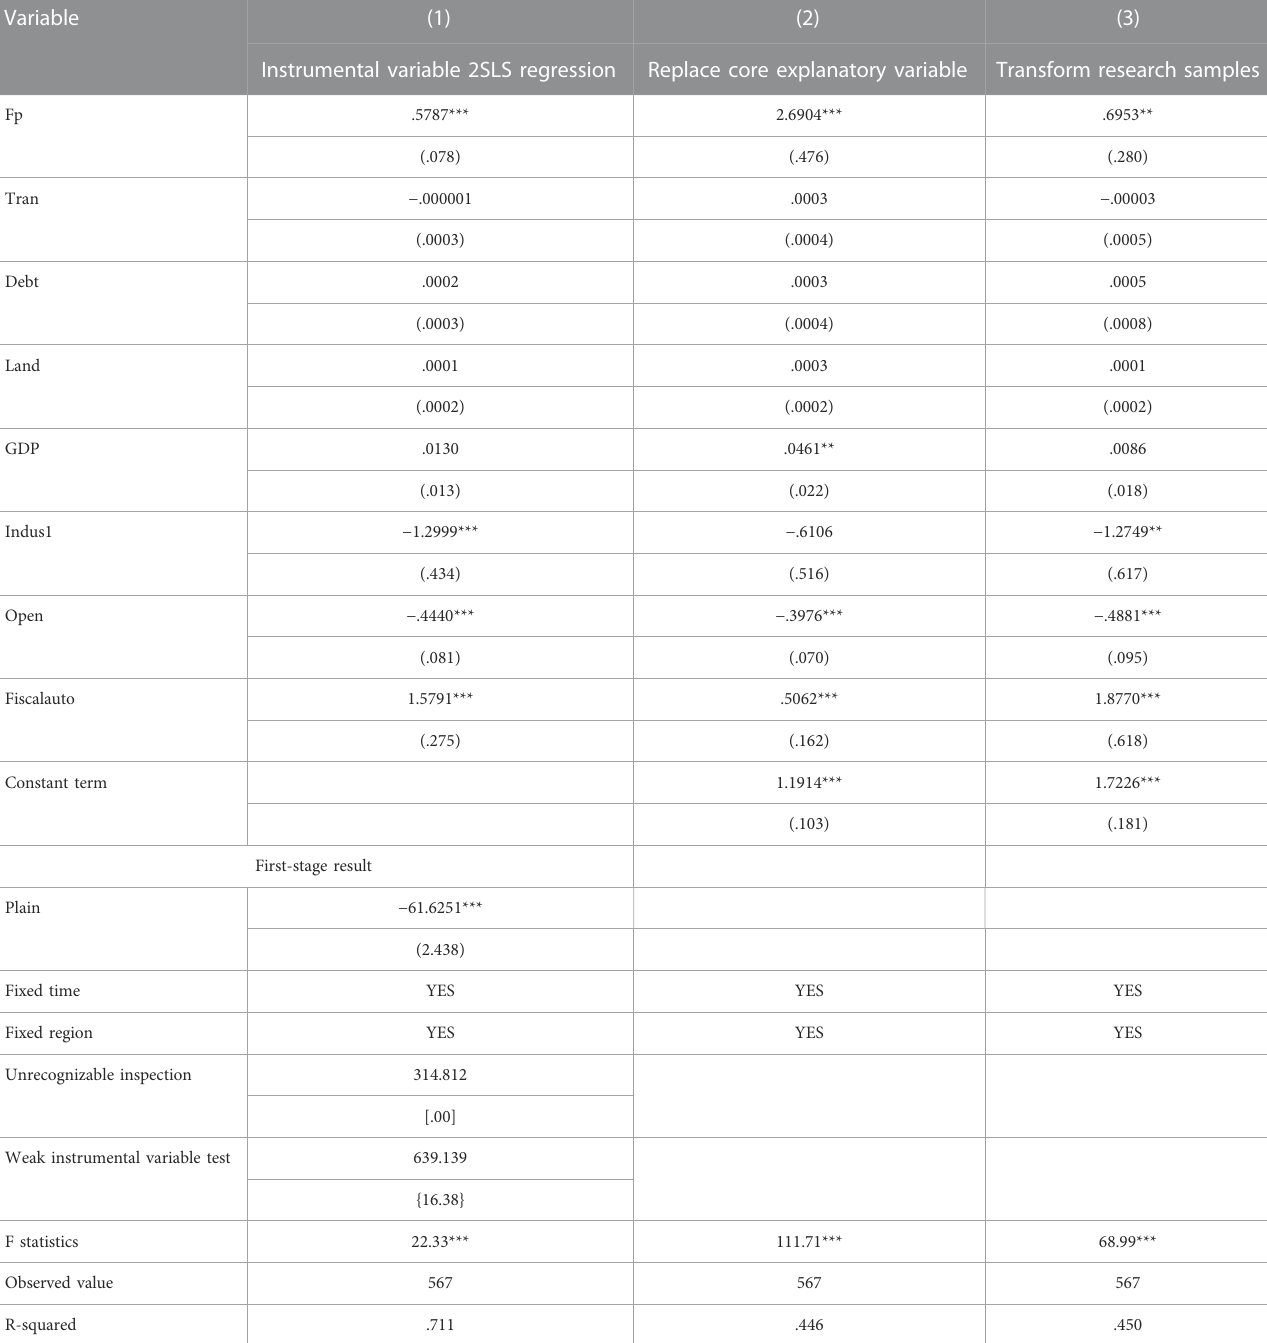
TABLE 3 Robustness test